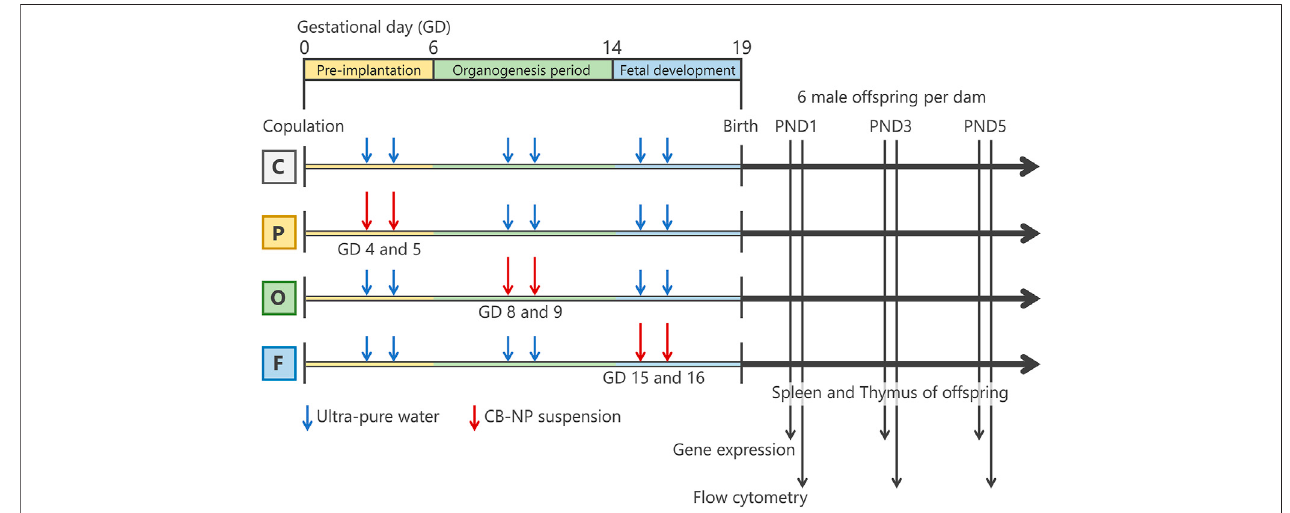
FIGURE1| Summarizedschemeofanimaltreatmentsandsamplecollection.Pregnantmicewererandomlydividedintofourgroups;controlgroup(Cgroup; n (cid:2) 8), pre-implantationperiodexposuregroup(Pgroup; n (cid:2) 9),organogenesisperiodexposuregroup(Ogroup; n (cid:2) 7),andfetaldevelopmentalperiodexposuregroup(Fgroup; n (cid:2) 7). The pregnant mice were intranasally exposed to carbon black nanoparticle suspension (95 μ g/kg body weight) at gestational days 4 and 5 for the P group, gestational days 8 and 9 for the O group, and gestational days (GDs) 15 and 16 for the F group. The control group were treated with the same volume of ultrapure watereach time. After childbearing, sixmale offspring per 1 dam were randomly selected and their spleen and thymus were collected at postnatal day (PND) 1, 3, and 5 for fl ow cytometry and gene expression analysis.